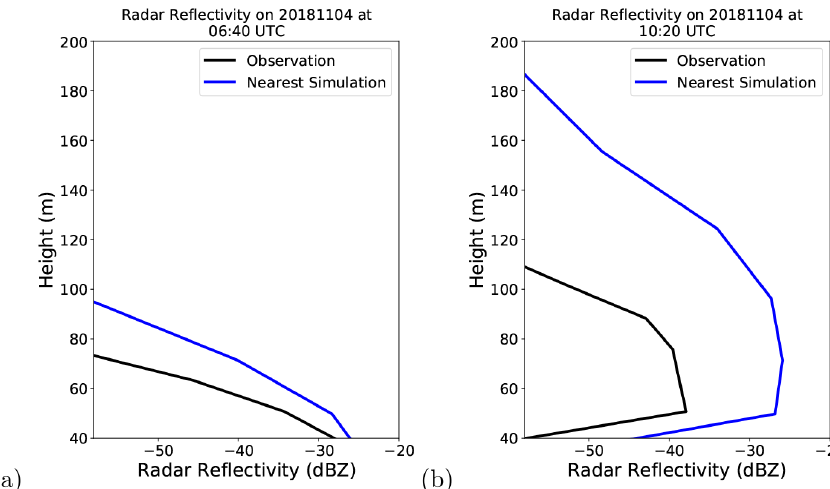
Figure 2. Observed and simulated radar reflectivity from the radiative fog event during the mature phase (a) and dissipation phase (b) . The black line shows the radar reflectivity measured with the BASTA cloud radar situated at SIRTA. The blue line shows the simulated radar reflectivity from the AROME model forecast, valid at the same time and grid point as the